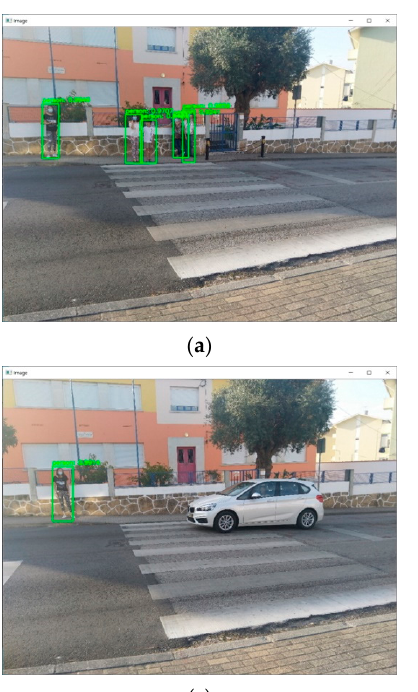
Figure 9. Test scenario with single region of interest (ROI) (crosswalk).